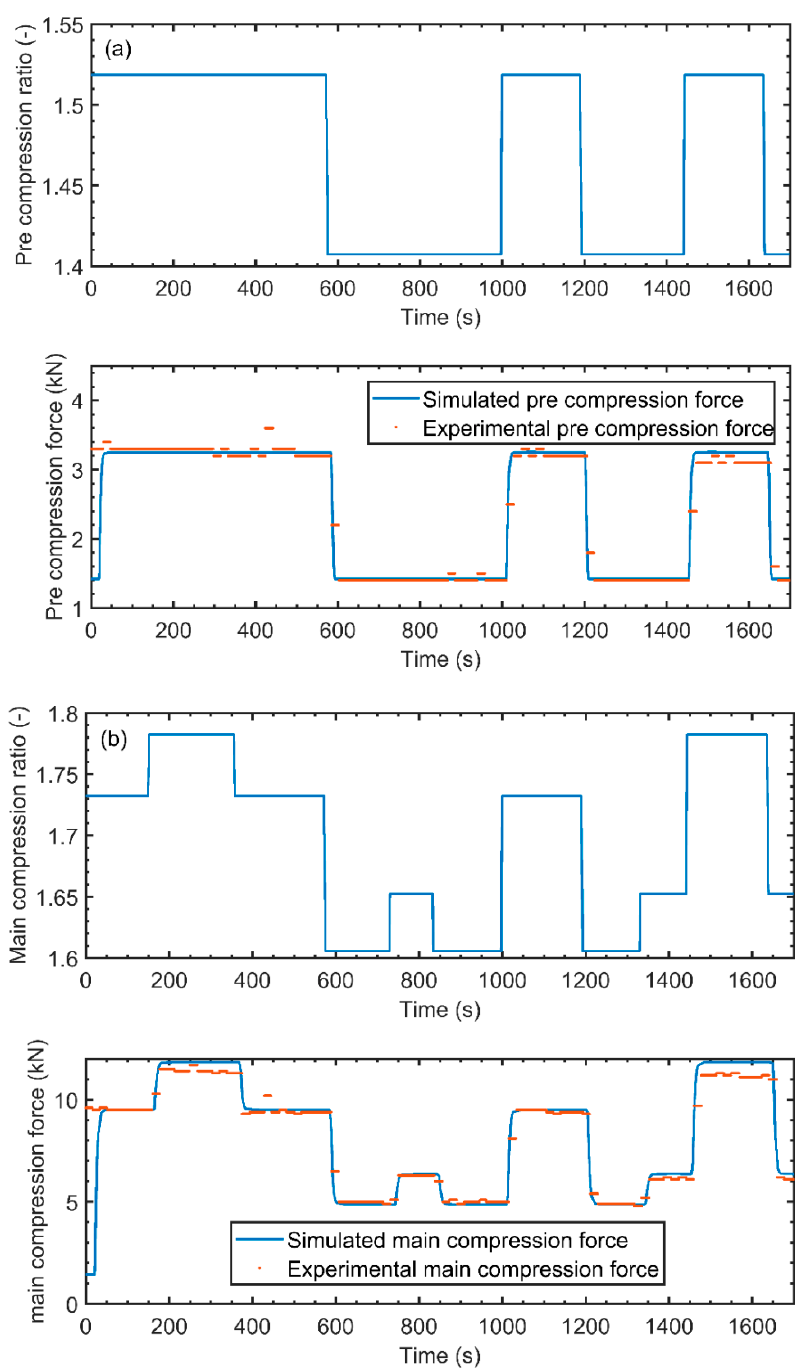
Figure 6. ( a ) Pre-compression force model validation ( b ) Main compression force model validation.